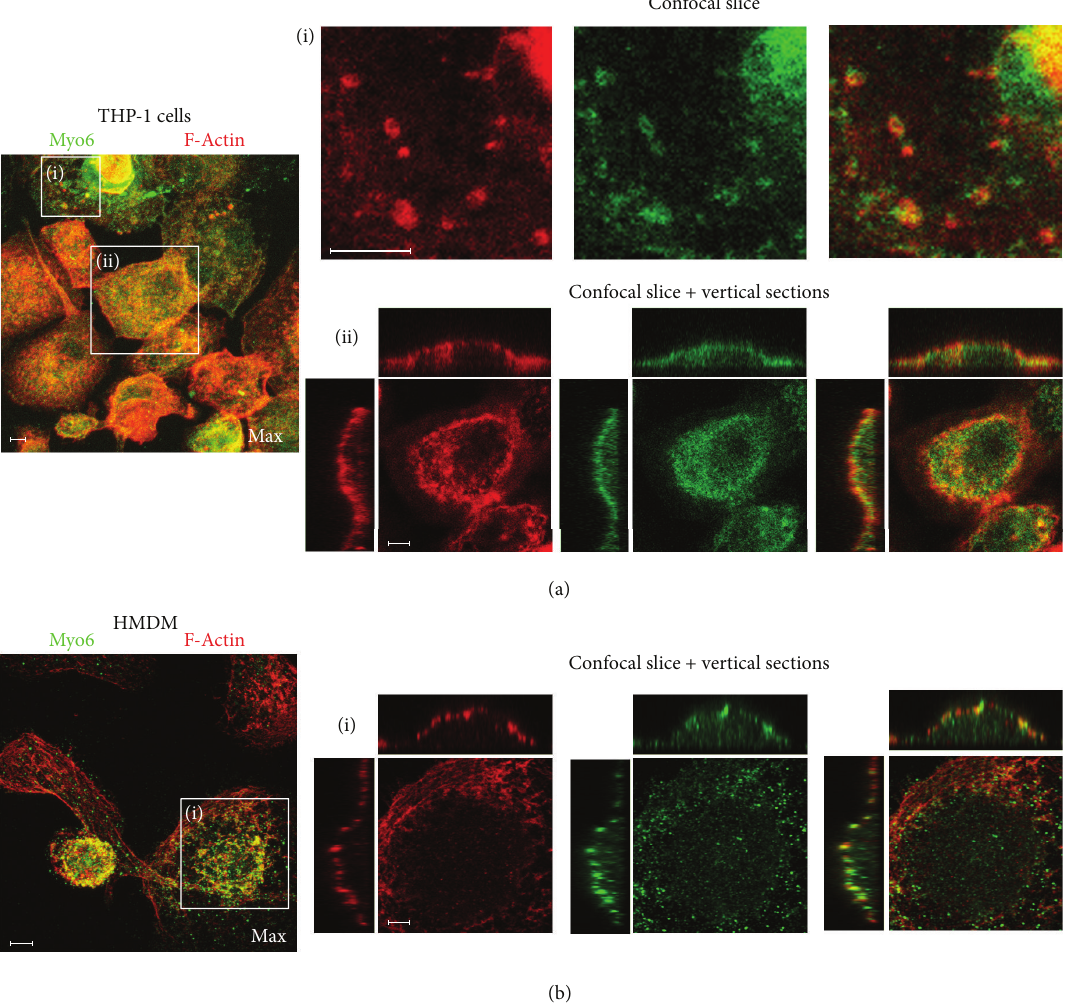
Figure 6: Relative distributions of Myo6 and F-actin in THP-1 macrophages and HMDM. THP-1 macrophages (a) or HMDM (b) were fixed and probed using double immunofluorescence for Myo6 (secondary antibody conjugated to Alexa488 (green)) and F-actin (visualised using rhodamine-conjugated phalloidin (red)); Z-stacked images were taken on a Zeiss LSM or Leica SP5 confocal microscope. Maximum projections are shown on the left for orientation. (a) (i) shows a confocal slice at the level of the bottom of the cells, taken from the region indicated to the left. The individual channels for F-actin (red), Myo6 (green), and the overlay are shown side-by-side. (a) (ii) and (b) (i) show single confocal sections and vertical xz and yz sections through the centre of the cells indicated to the left. The individual channels for F- actin (red), Myo6 (green), and the overlay are shown side-by-side. Typical images from at least 3 separate experiments with of THP-1 cells or HMDM from 3 individual donors are shown. Scale bars = 10 𝜇